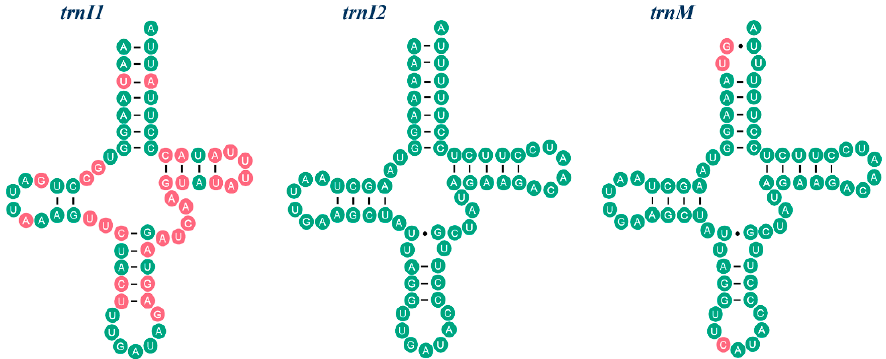
Figure 2. The secondary stem-loop structure and sequence similarity of trnI1 , trnM and trnI2 . Inferred Watson-Crick bonds are illustrated by lines, whereas GU bonds are illustrated by dots. Sequences of trnI1 and trnM are compared with trnI2 respectively. The identical nucleotides with trnI2 are labeled with green circles. The variable nucleotides are highlighted in red.